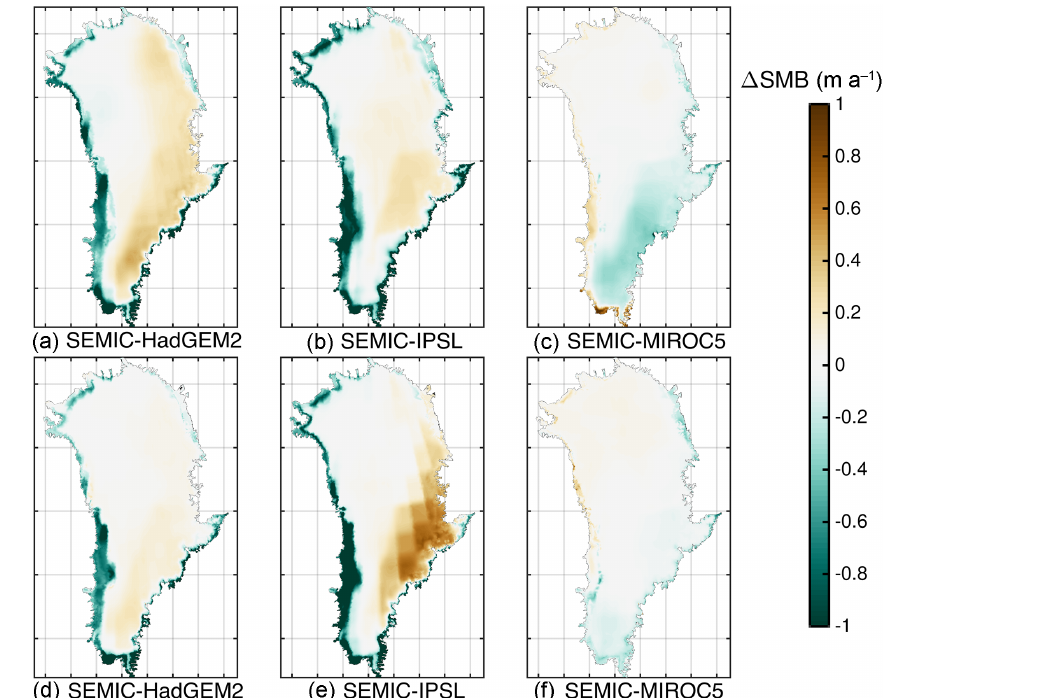
Figure 8. Comparison of multi-year mean surface mass balance (SMB) differences between 2100–2000 (a–c) and 2300–2000 (d–f) for